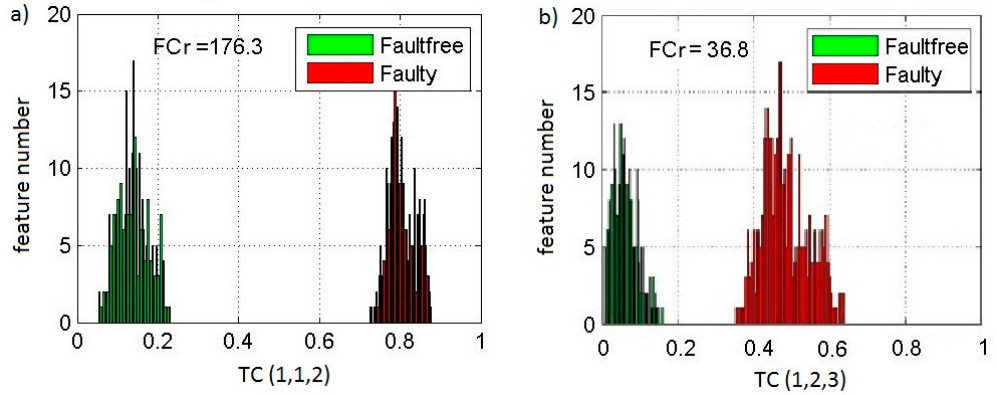
Figure 2. ( a ) The histograms of the magnitudes of the triple correlation TC (1,1,2); ( b ) The histograms of the magnitudes of the triple correlation TC (1,2,3).